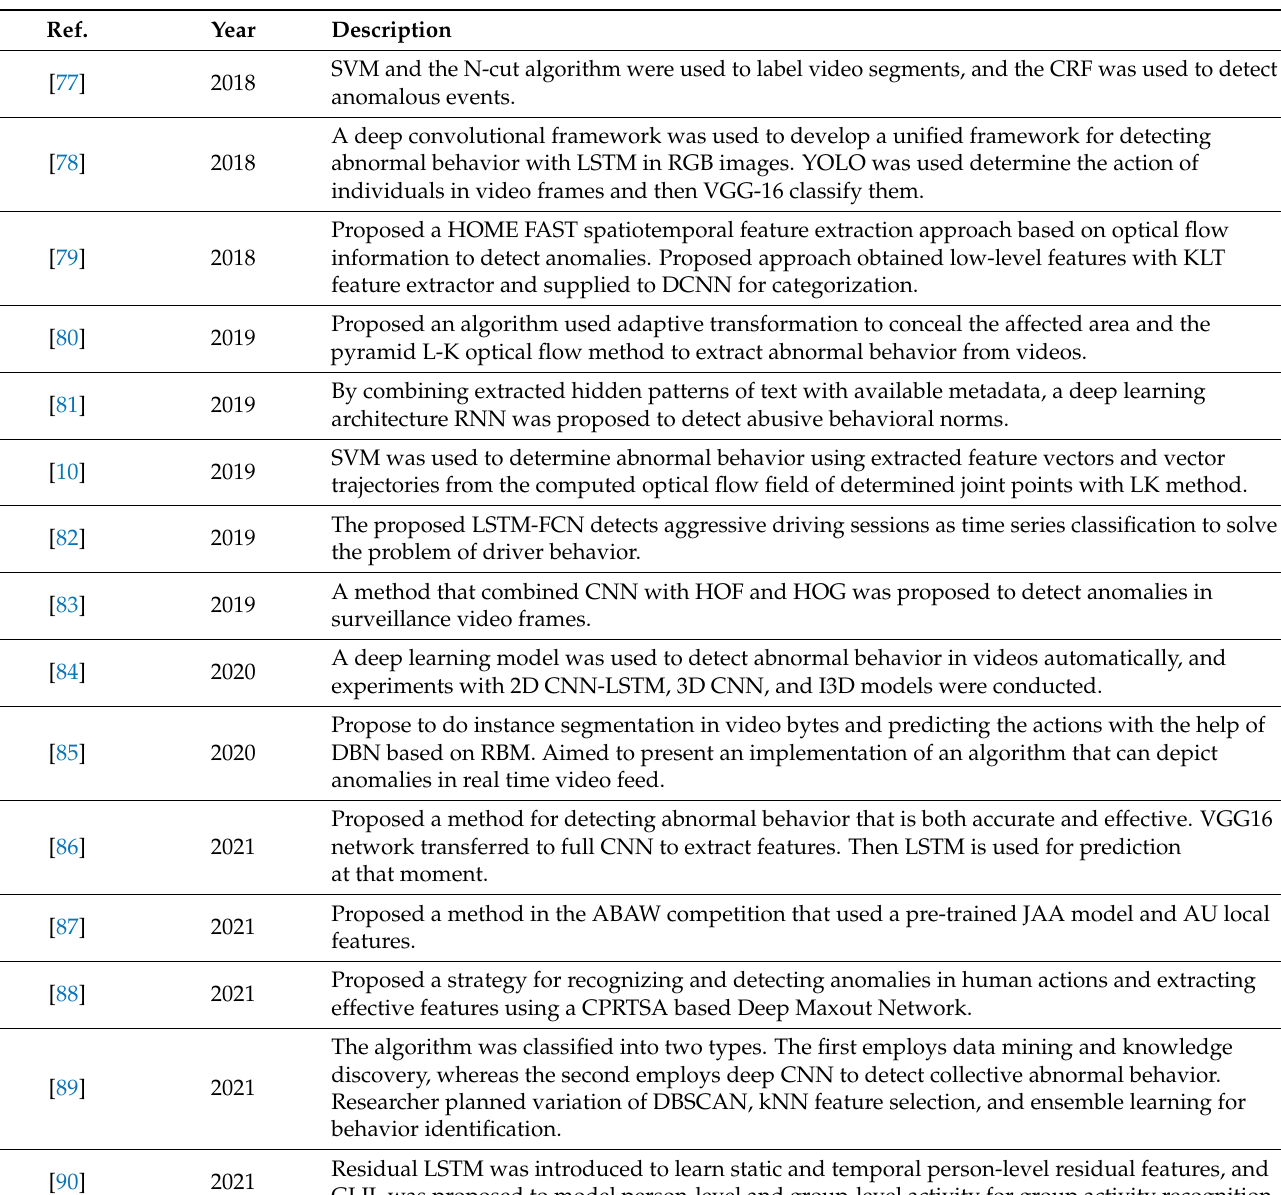
Table 6. Summary of literature on induvial user-based HAR.